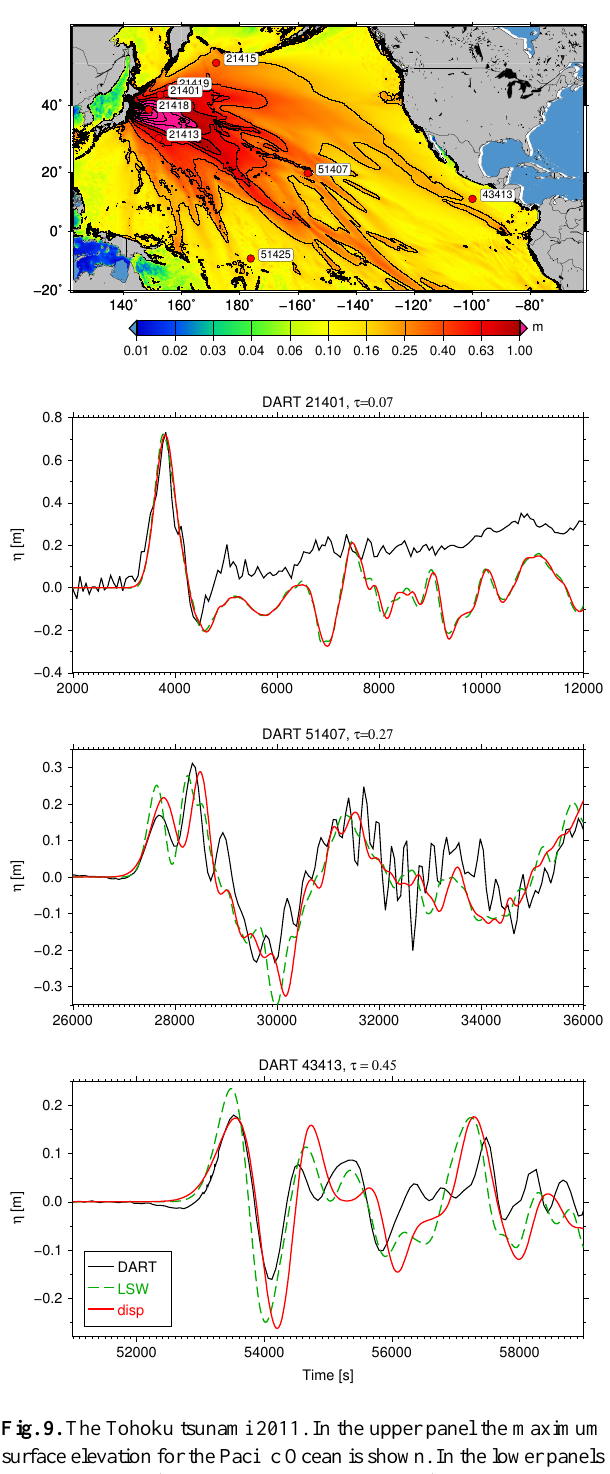
Fig. 9. The Tohoku tsunami 2011. In the upper panel the maximum surface elevation for the Pacific Ocean is shown. In the lower panels the mariograms (for three of the DART buoys) for the computed surface elevations for the linear shallow water (“LSW”) and linear dispersive (“disp”) solutions are compared to the measured surface elevations (“DART”).